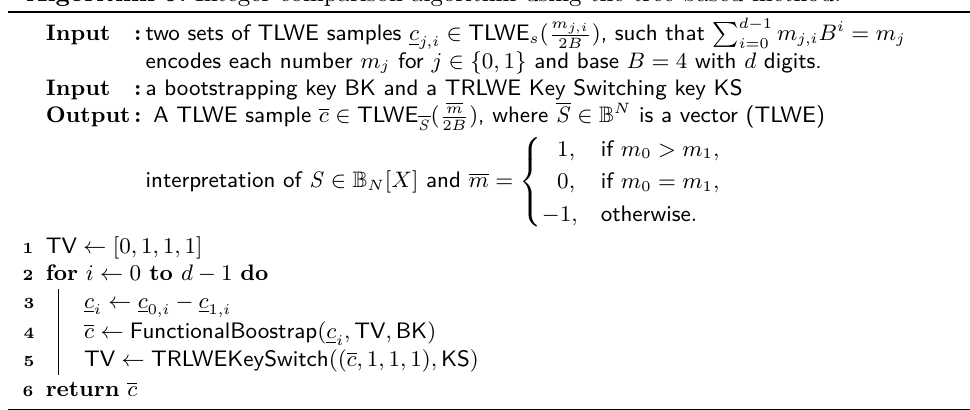
Algorithm 9: Integer comparison algorithm using the tree-based